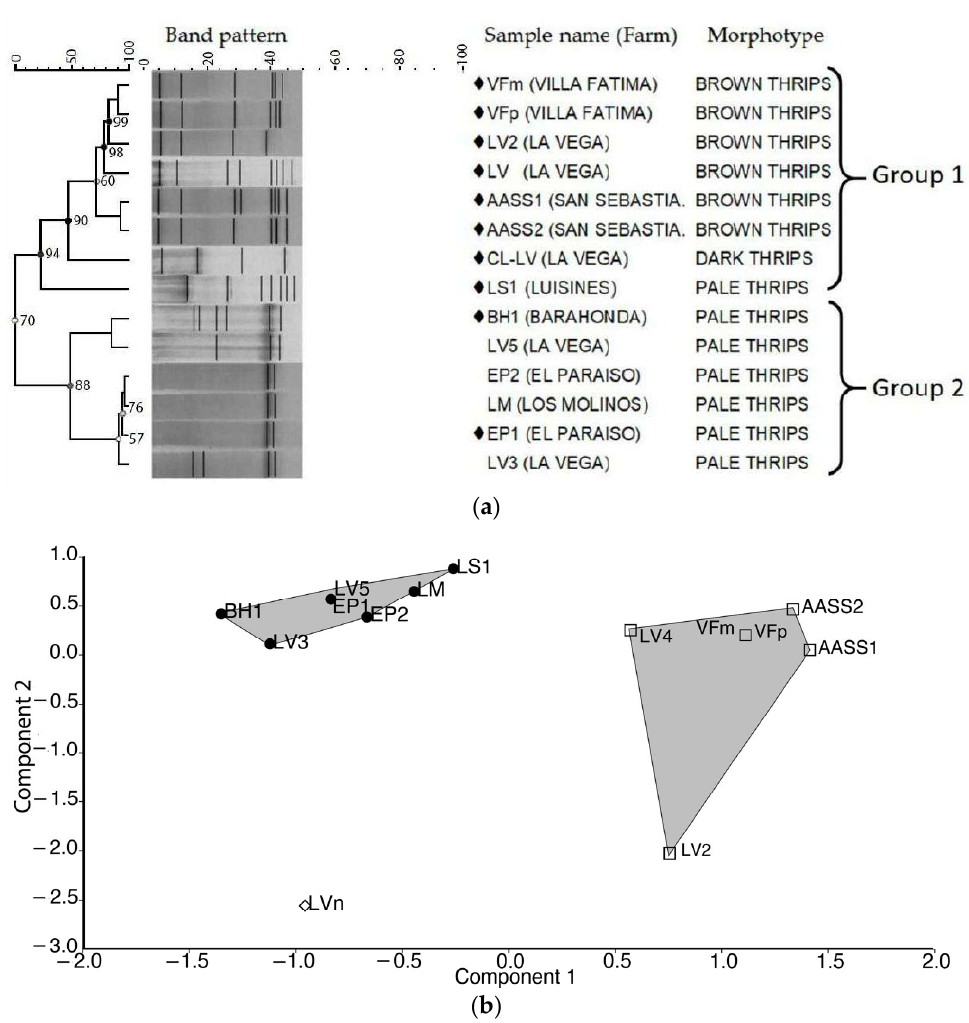
Figure 3. Information from independent ‐ culture samples. ( a ) Clustering analysis by the Pearson and complete ‐ linkage method of the PCR ‐ TGGE profiles of the 16S rDNA amplification products (V3 ‐ V6 variable regions) using the GelCompar II software. Each band is assumed to represent a taxonomic unit and therefore the profiles reflect the bacterial diversity obtained. Nomenclature: Group 1: isolates of S. hansoni (brown morphotype) that came from the farms La Vega (LV), Villa Fátima (VFm and VFp) farms San Sebastian (AASS1 and AASS2), La Vega (LV2), F. panamensis (morphotype dark) La Vega farm (LVn), and Frankliniella sp. (pale morphotype) Luisines farm (LS1); Group 2: isolates of Frankliniella sp. (pale morphotype); the samples were Barahonda (BH1), Luisines (LS1), El Paraíso (EP1, EP2), Los Molinos (LM), and La Vega (LV3 and LV5). The samples that have the symbol ♦ were the selected samples used for the metataxonomic analysis. ( b ) Analysis of the main component of the quantitative TGGE matrix of the three thrips morphotypes. S. hansoni (brown morphotype); LV4, VFm, VFp, AASS1, AASS2 and LV2 ( □ ), Frankliniella sp. (pale morphotype); BH, LS, LM, EP1, EP2, LV3 and LV5 ( ● ), and F. panamensis (dark morphotype); CL ( ◊ ).